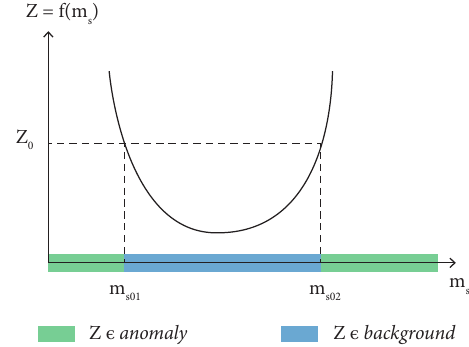
Figure 2. Relationship between the threshold of SDS Z 0 and the boundary in moment space (straight line in the one-dimensional case). SDS = sufficient decision